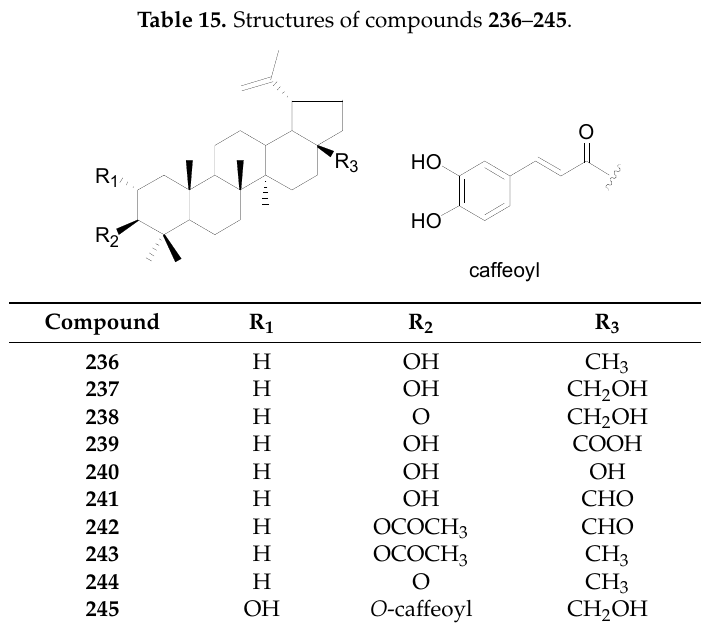
Figure 10. Structures of compounds 224 – 235 . Table 15. Structures of compounds 236 – 245 .